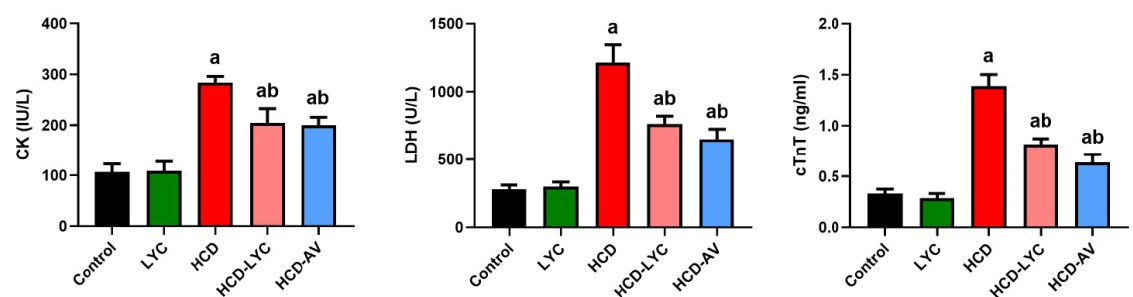
Figure 2. Effects of dietary cholesterol and lycopene on serum creatine kinase MB (CK), lactate dehydrogenase (LDH), and cardiac troponin T (cTnT) in rats over 12 weeks. Letters a and b indicate statistically significant differences between control and HCD groups, respectively, at p < 0.05.